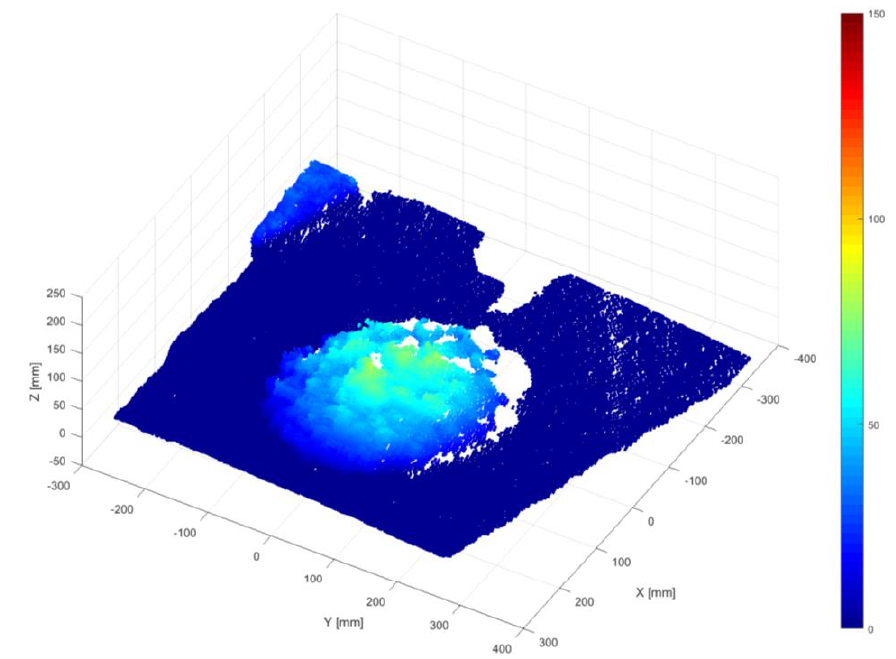
Figure 8. Concrete slump described in frame {S}.